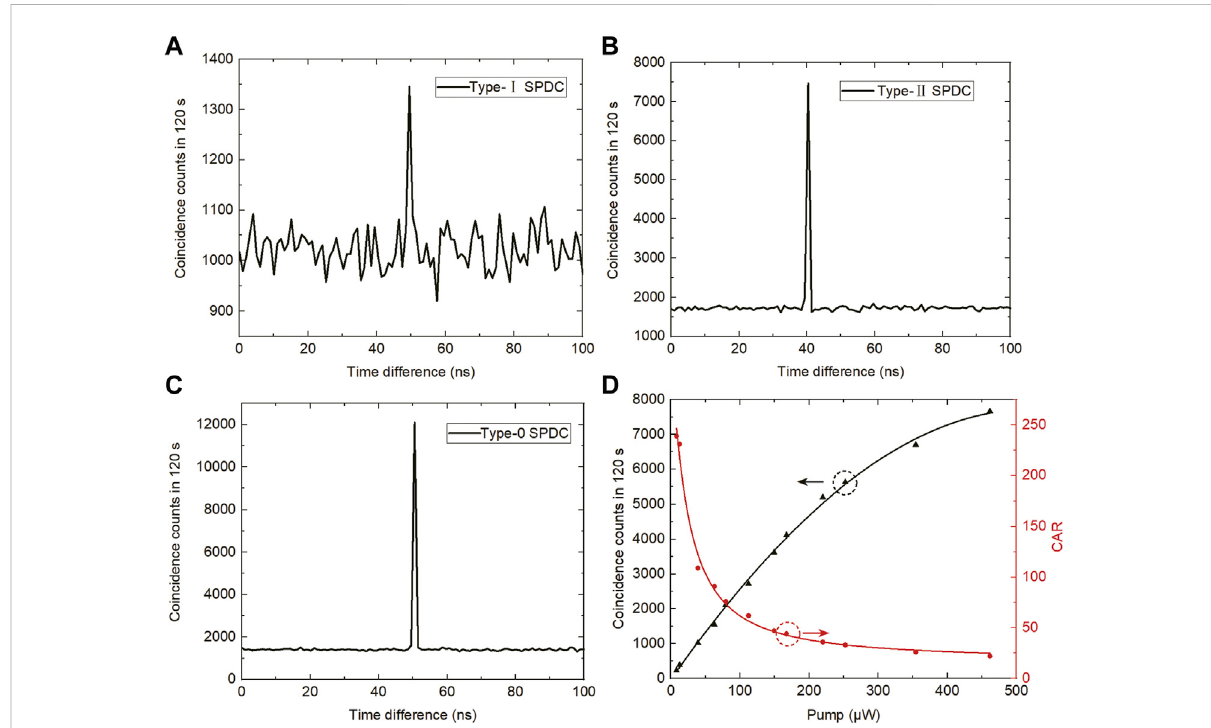
FIGURE 5 Histograms of the coincidence measurements for type-I (A) , type-II (B) and type-0 (C) (D) Coincidence counts of type 0 as a function of the average input pump power. The points are experimental data, and the curves are fi ts. All the data are raw counts and no background counts